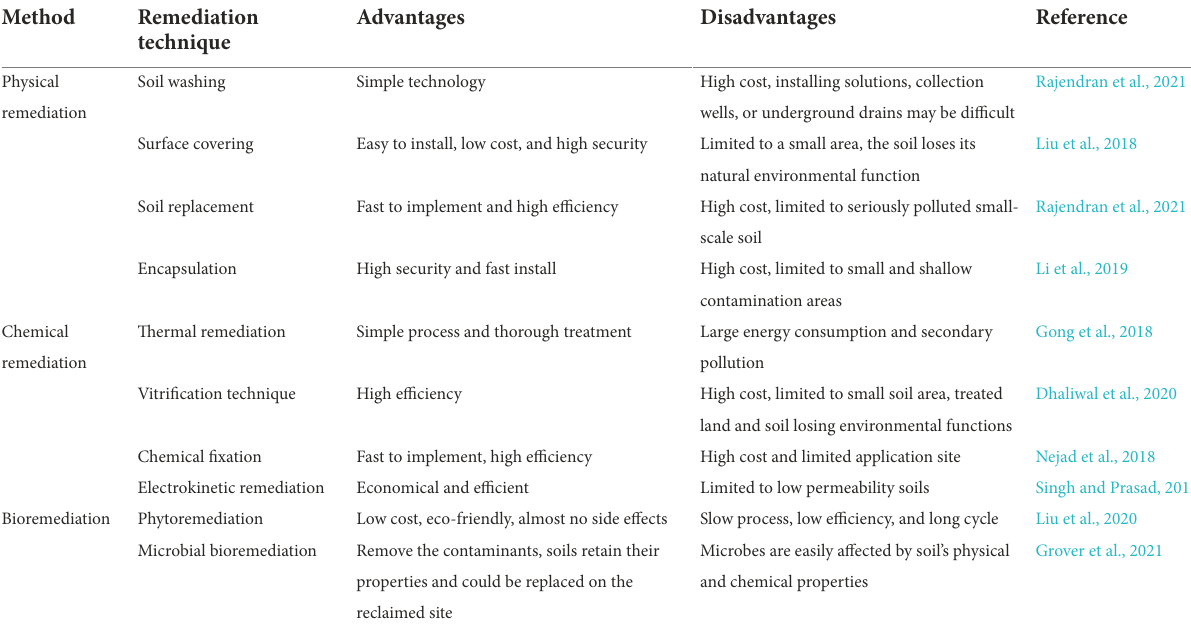
TABLE 2 Advantages and disadvantages of the available remediation techniques for metal-contaminated soils.